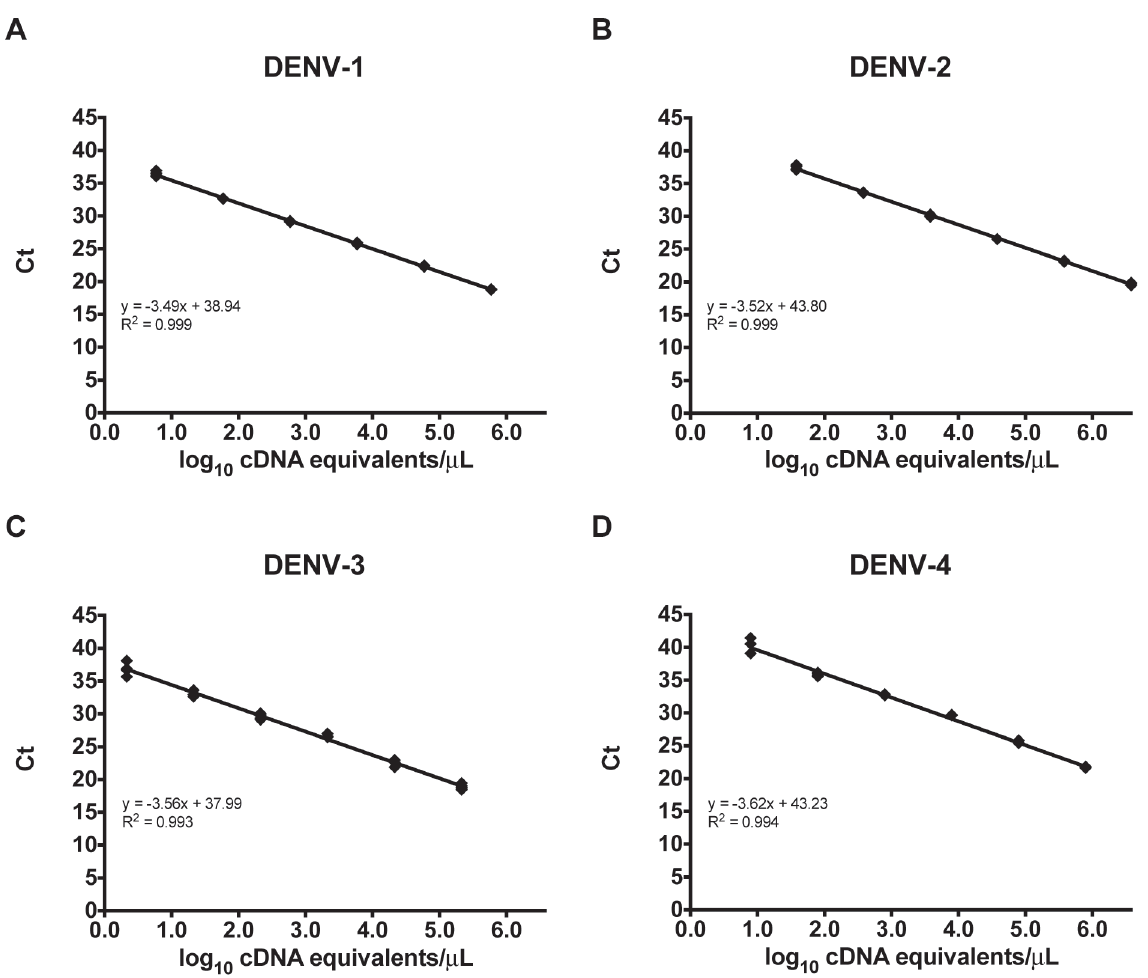
Figure 1. The linear range for the multiplex rRT-PCR assay is shown for DENV-1 (A), DENV-2 (B), DENV-3 (C), and DENV-4 (D).